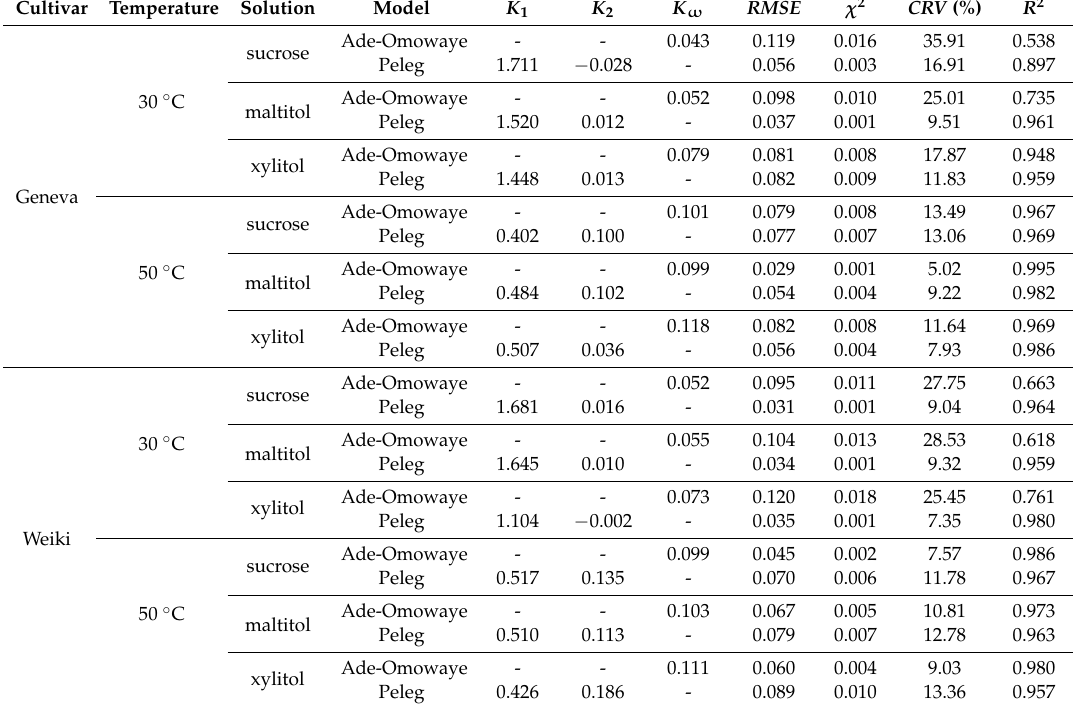
Table 5. Values of RMSE , χ 2 , R 2 and CRV of best fitting mathematical model of WL. Cultivar Temperature